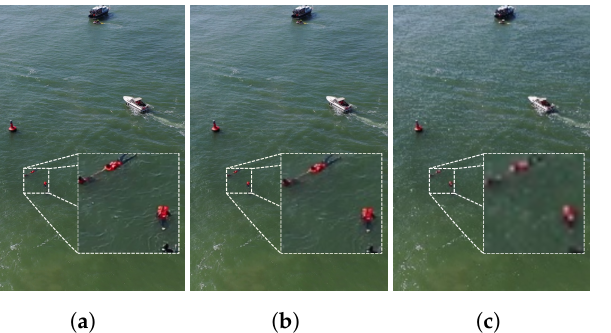
Figure 3. Example images for image resolutions with max side length. ( a ) Full resolution; ( b ) Max 768 pixels; ( c ) Max 256 pixels.